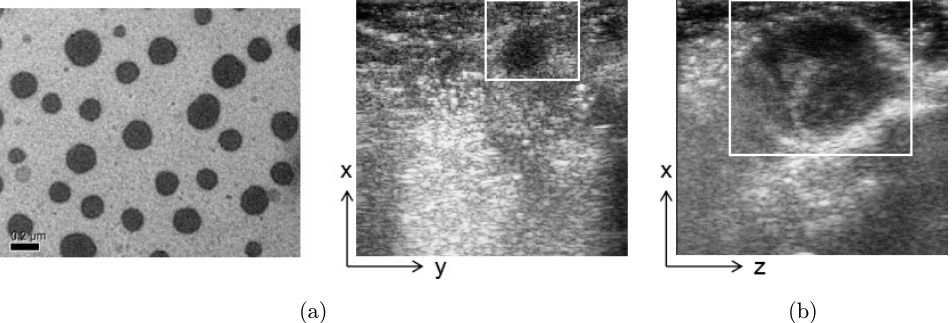
Fig. 4. In vivo PA imaging. (a) TEM image of nanoprobe. (b) Ultrasonic (B-mode) images of tumor. (c) PA images before and 1, 4, 8, 12 and 24 h i.e., postinjection of Cy7- (cid:1) -gal-LP (100 (cid:2) L, 50 (cid:2) g mL (cid:1) 1 Þ . (d) Region of tumor analysis of the PA intensity in mice after the injection of Cy7- (cid:1)